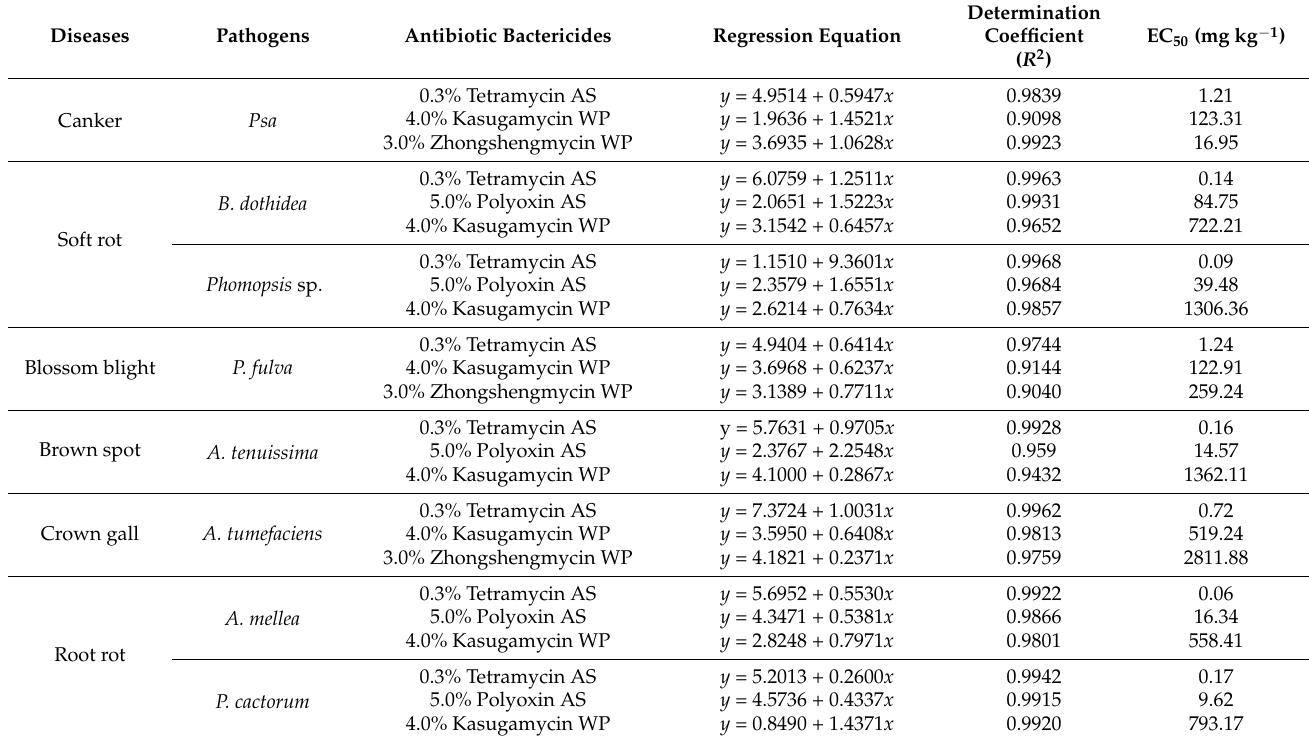
Table 1. Toxicities of different antibiotics against eight pathogens of kiwifruit.